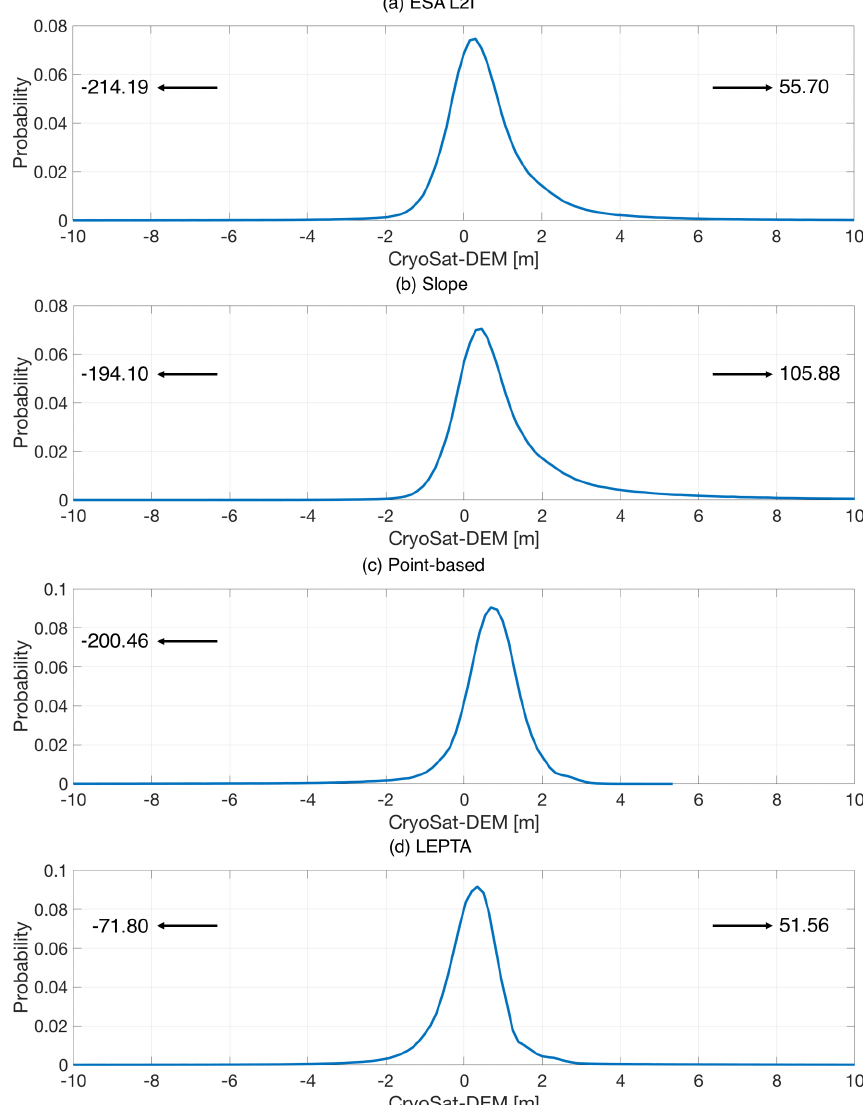
Figure B1. Probability distribution functions of heights between CryoSat-2 and ArcticDEM derived from (a) ESA L2I, (b) the slope method, (c) the point-based method, and (d) LEPTA centred between − 10m and 10m. To clearly show minimum and maximum values (values displayed with arrows), the curves are not displayed in the same